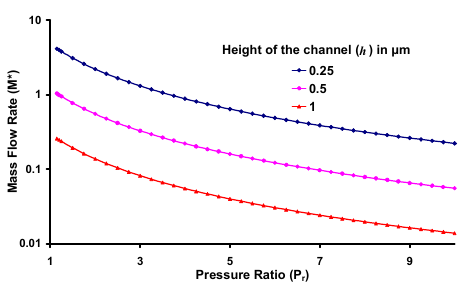
Fig. 5: Plot of normalized mass flow rate (ratio of diffusion mass flow rate to the convection mass flow rate) as a function of pressure ratio.